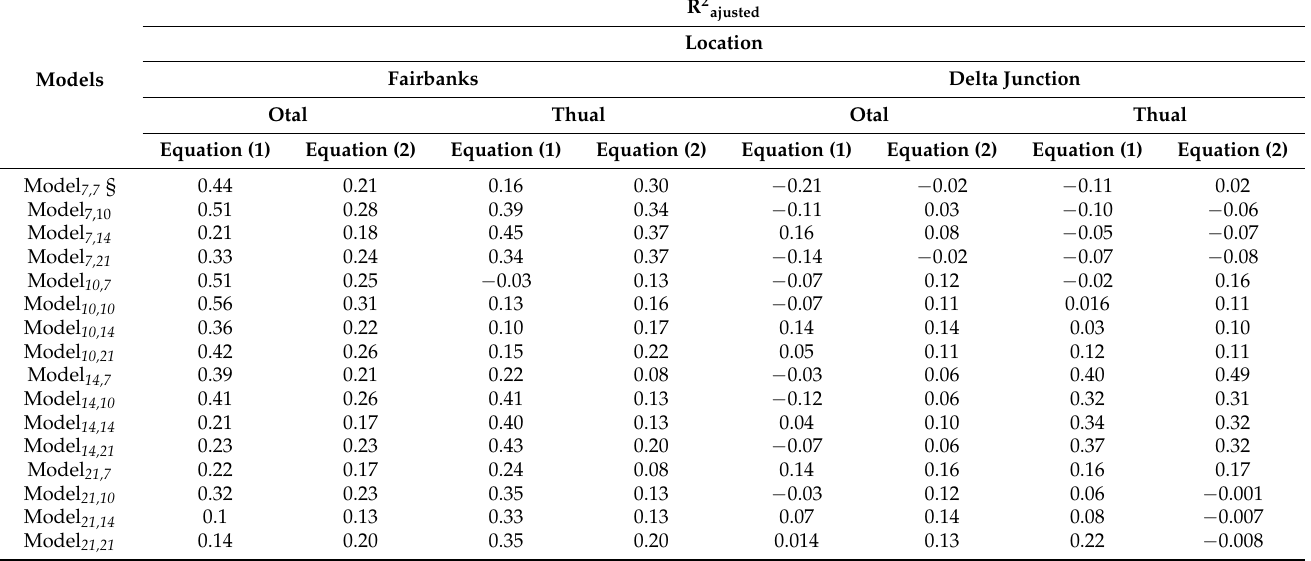
Table 3. R 2 ajusted of multiple linear modes from Equations (1) and (2). The dependent variable is ∆ Log(Yield) and the independent variables are ∆ X1, ∆ X2, ∆ X3, ∆ X4, ∆ X5, and ∆ X6 which represent first difference values of time series of TminBH, TdtrBH, PAH, TminAH, TdtrAH, and PAH at different days of BH and AH of cultivars (‘Otal’ or ‘Thual’) at locations (Fairbanks or Delta Junction). R 2